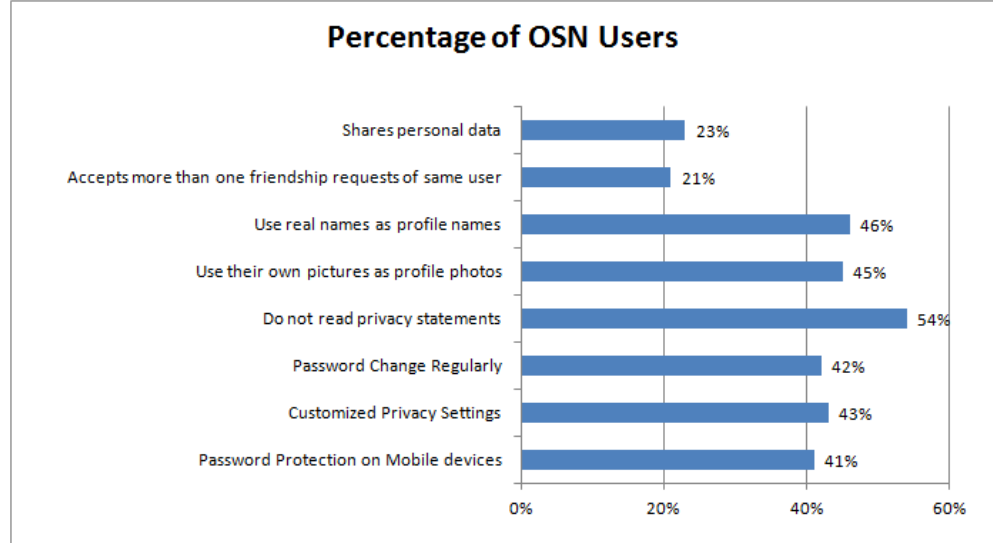
Figure 1. Percentage of users who either do not know or care about their privacy while using